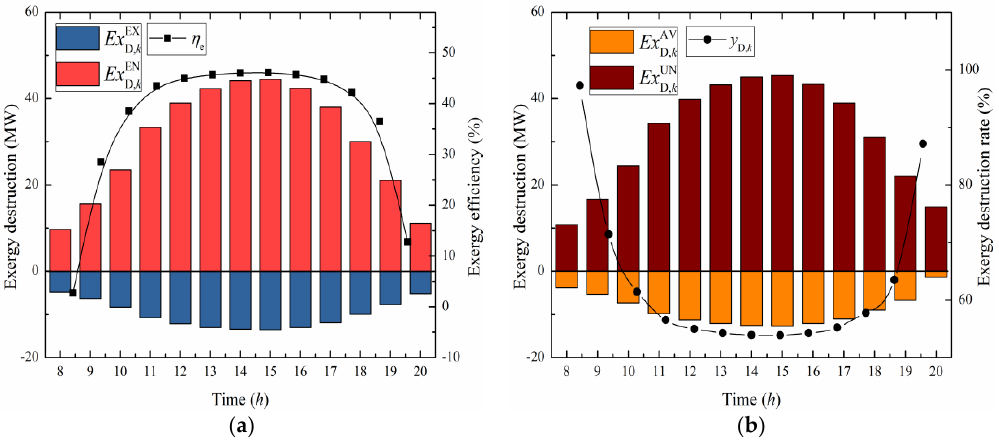
Figure 9. The exergy destruction, exergy efficiency and exergy destruction rate of solar field variation with time. ( a ) The endogenous/exogenous exergy destruction and exergy efficiency variation with time. ( b ) The avoidable/unavoidable exergy destruction and exergy destruction rate variation with time.